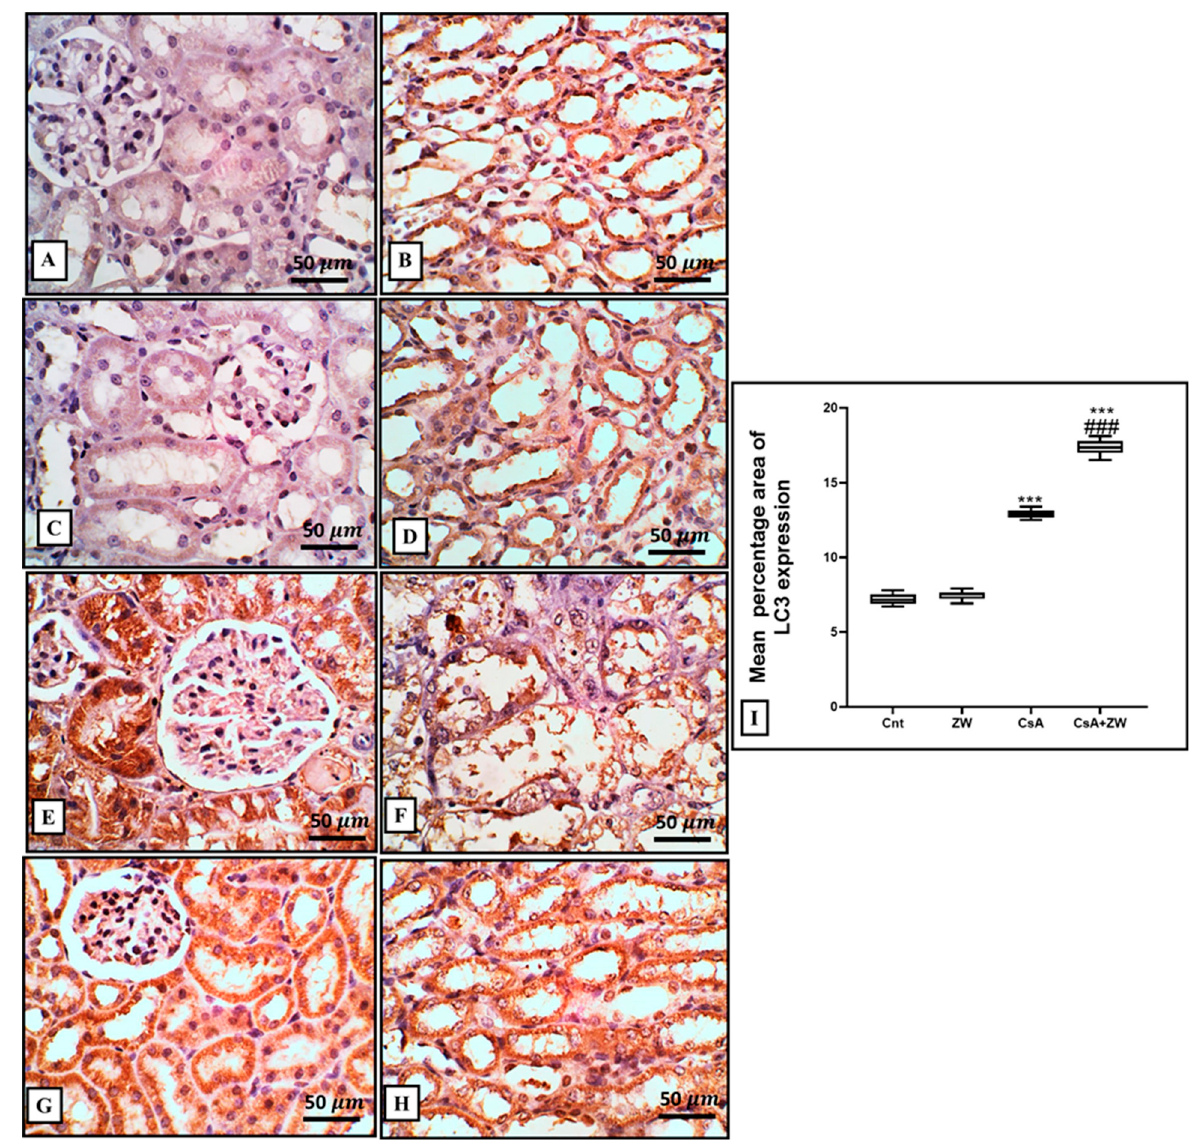
Figure 9. Representative immunohistochemical assessment of LC3 expression in the kidney. ( A – D ) The control and ZW groups show none-to-few faint expressions in cortical tubules without glomerular expression and di ff use expression in the cytoplasm of medullary tubules. ( E , F ) The CsA group shows di ff use strong expression in the cytoplasm of necrotic, sloughed, and vacuolated cortical cells, with few glomerular expressions and a lower expression in medullary tubular cells (intraluminal sloughed cells and intraluminal cast). ( G , H ) The CsA+ ZW group shows di ff use cortical and medullary tubular expression with low glomerular expression. (I) Histogram of the percentage area of the immunostaining of renal LC3. *** p < 0.001 vs. control ; ### p < 0.001 vs. CsA. Image magni fi cation = 400×; scale bar = 50 µm.